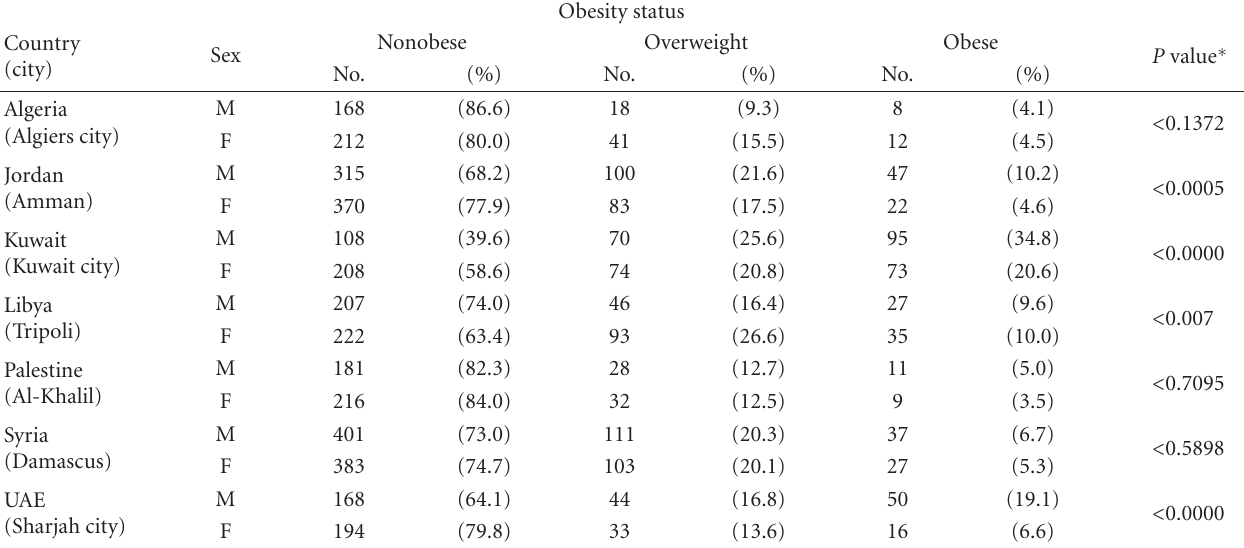
Table 2: Prevalence of overweight and obesity among adolescents (15–18 years) in seven Arab countries based on IOTF reference. Obesity